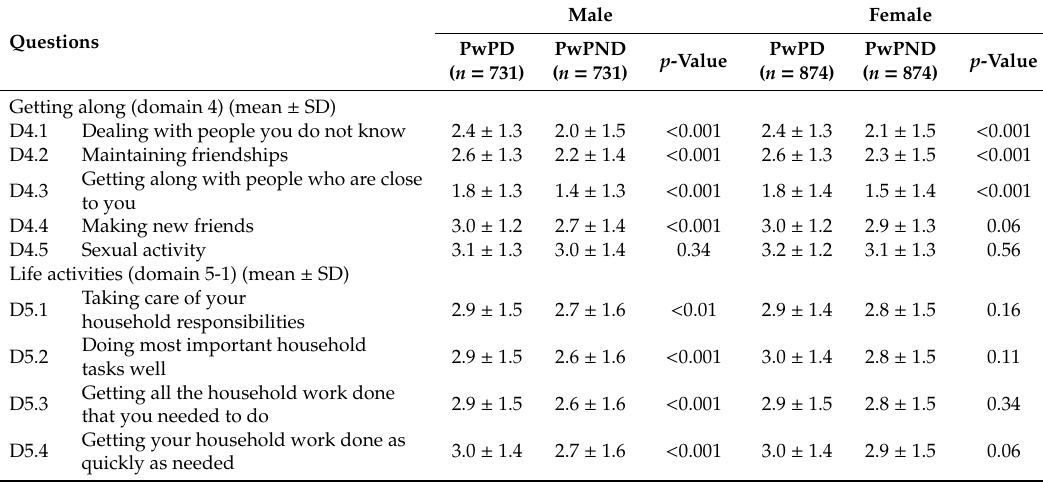
Table 3. Sub-analysis of scores for questions regarding getting along (domain 4) and life activities (domain